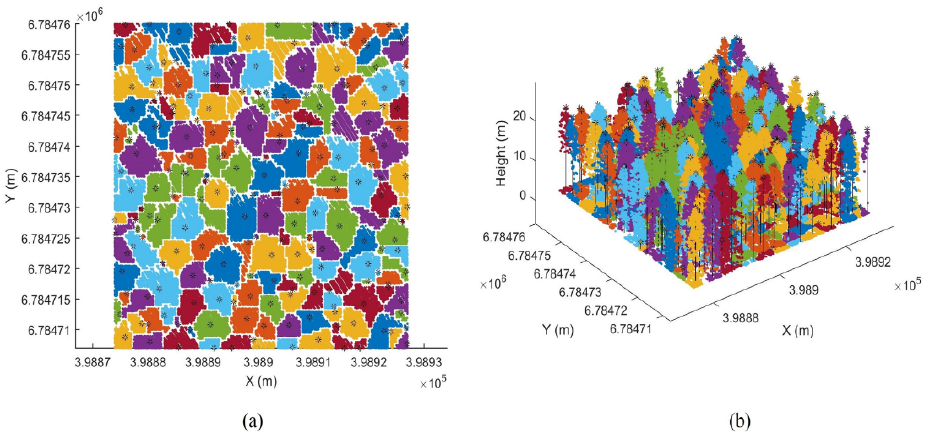
Figure 6. An example of the results of Yu et al. [51] tree detection stage from ( a ) a plan view and ( b ) a 3D view.